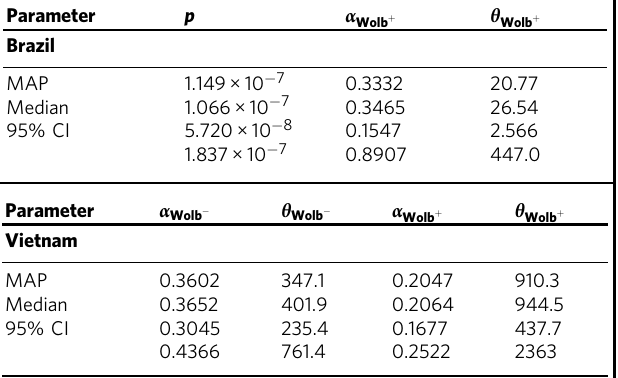
Table 1 Parameter estimates from dose-response model fi tting to experimental data Parameter